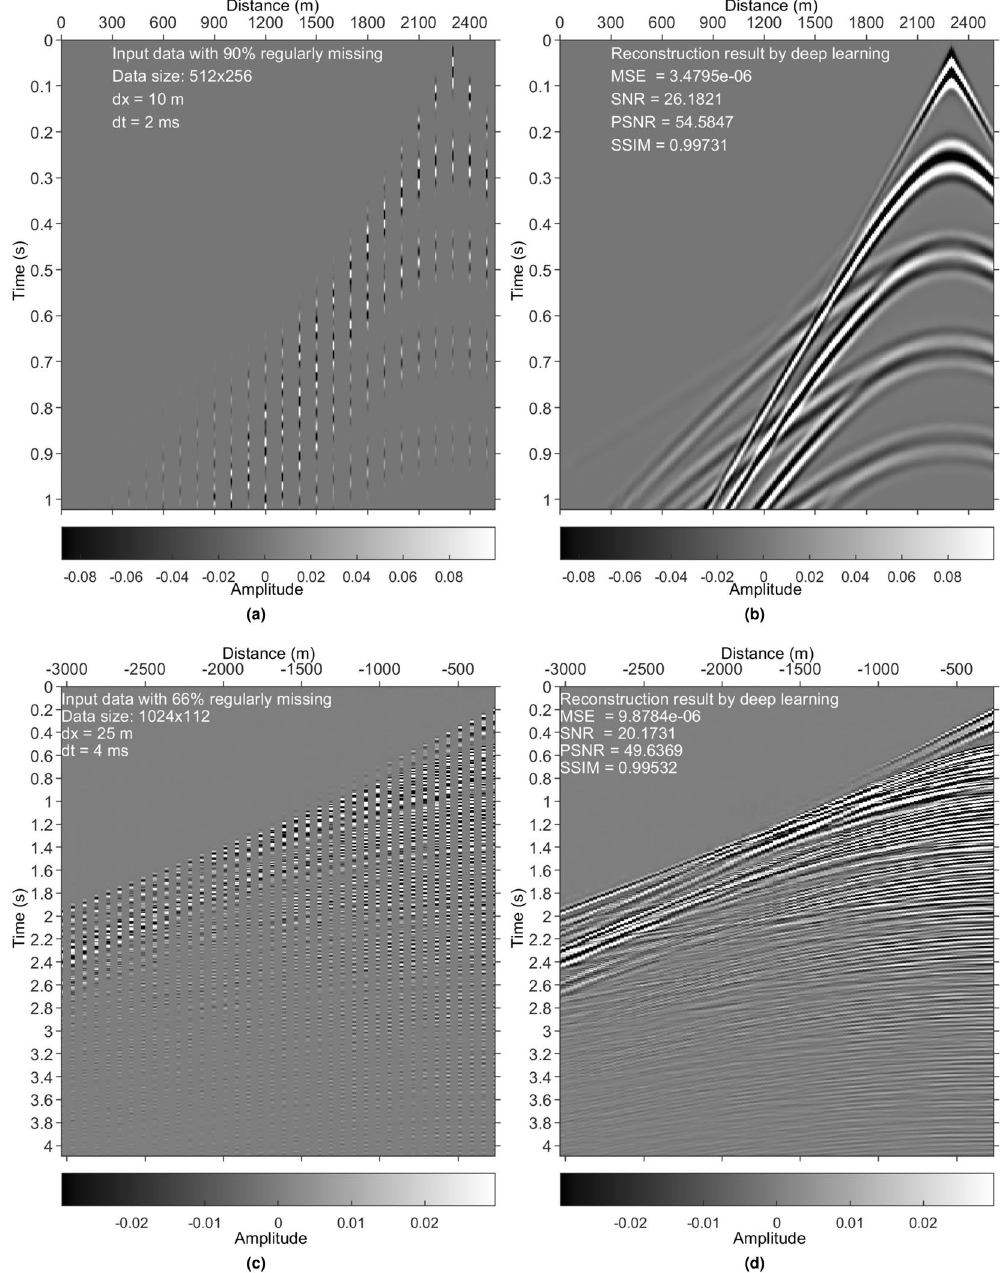
Figure 13. Regularly missing data reconstruction. ( a ) Regularly sampled data from the synthetic training data set with a decimation factor of 10 in the space direction (90% missing). ( b ) DL result for ( a ). ( c ) Regularly sampled data from the Mobil Viking graben line 12 data set with a decimation factor of 3 in the space direction (66% missing). ( d ) DL result for ( c